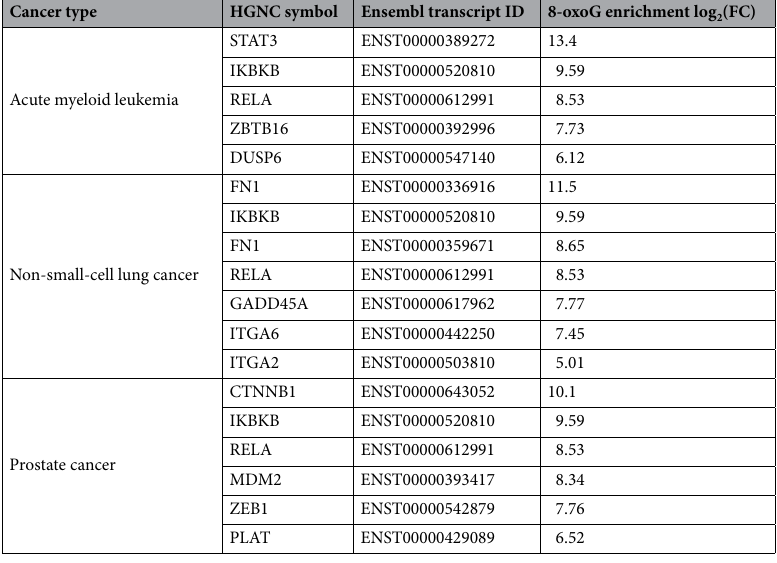
Table 2. Fold-change in 8-oxoG enrichment in transcripts involved in cancer pathways after formaldehyde